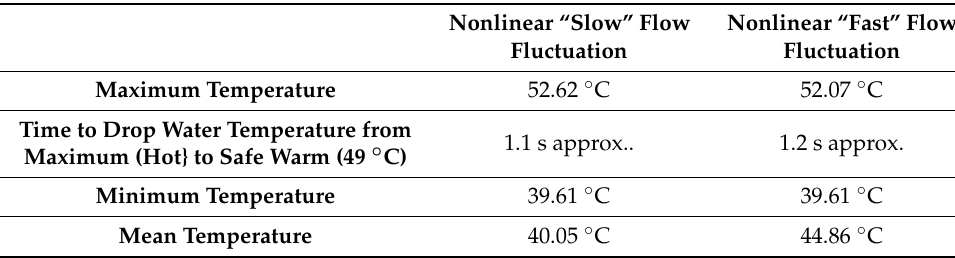
Table 2. Extreme test cases observations summary.